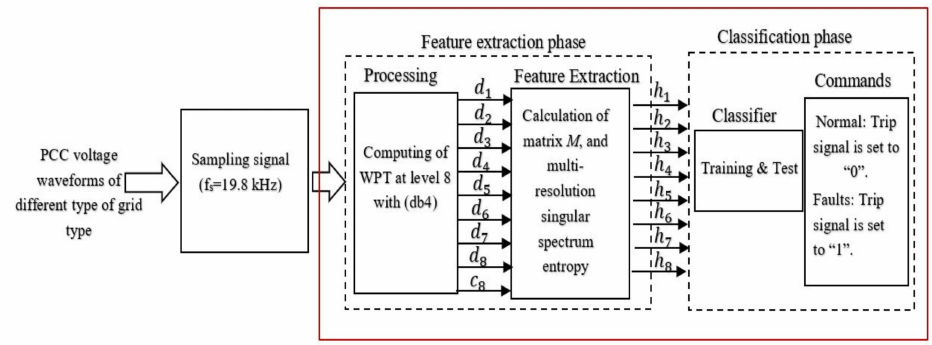
Figure 1. Structure of the proposed protection